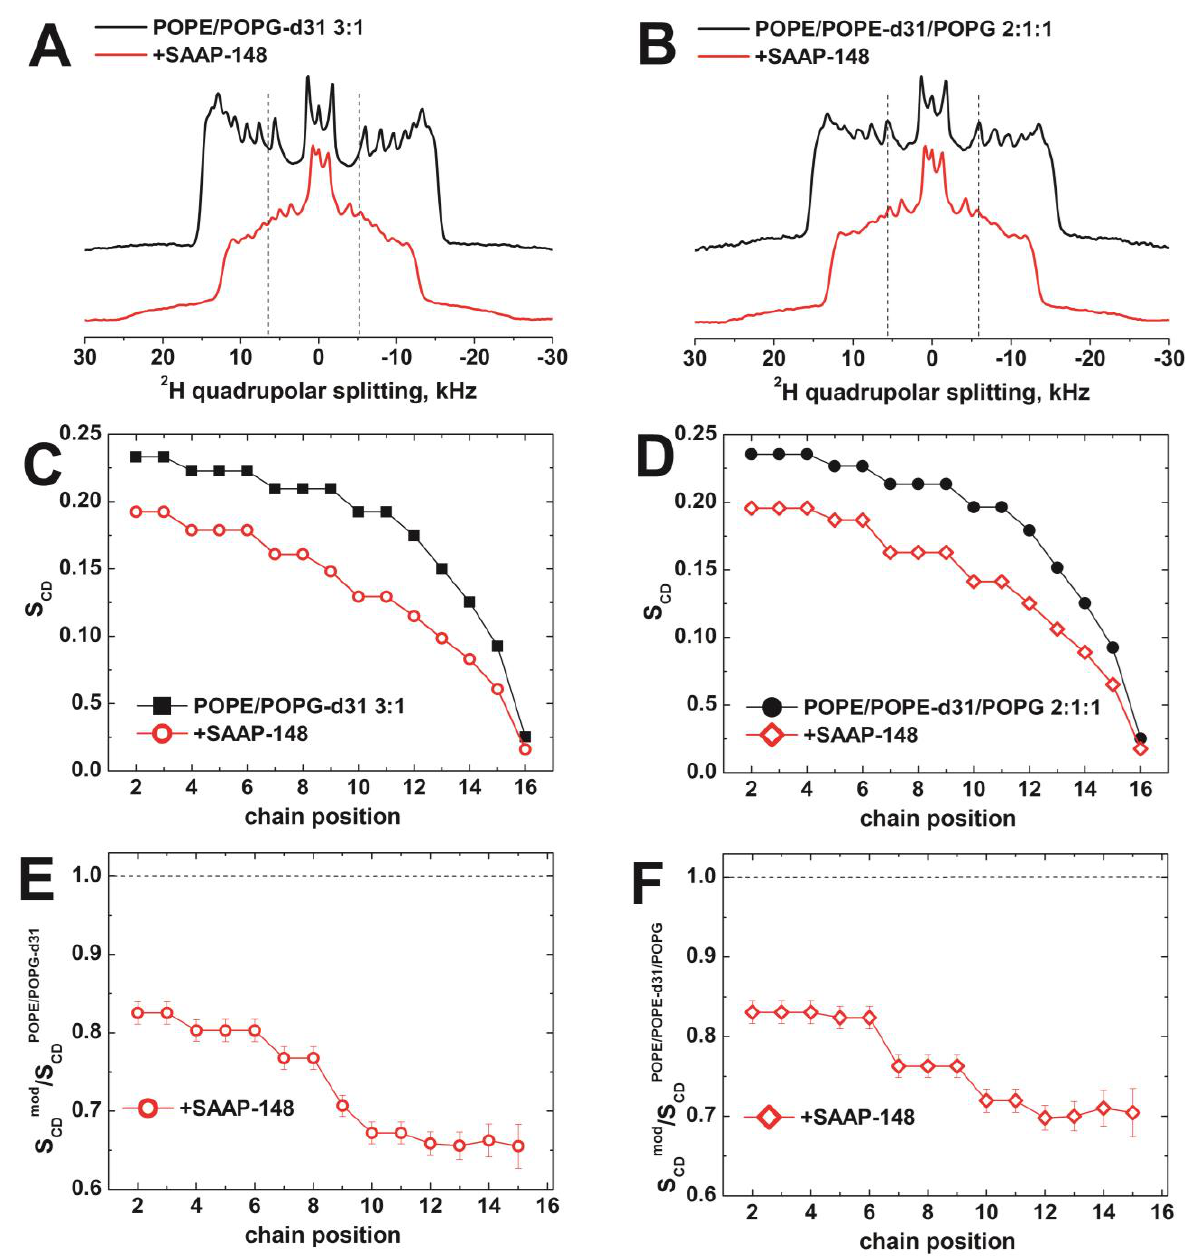
Figure 4. ( A , B ) Quadrupolar 2 H solid-state NMR spectra of chain-deuterated POPG-d 31 ( A ) or POPE-d 31 ( B ) in the presence or absence of SAAP-148 peptide at 2 mol% concentration at 310 K. Samples were hydrated with Tris buffer pH 7.4 to reach a water content of h = 0.81. ( C , D ) Order parameters S CD of lipid palmitoyl chain C – D bonds in the absence and in the presence of SAAP-148 for POPG-d 31 ( C ) and POPE-d 31 ( D ). The effect of SAAP-148 is more clearly evidenced when plotting the ratio of S CD in the presence of SAAP-148 with that in its absence ( E , F ).